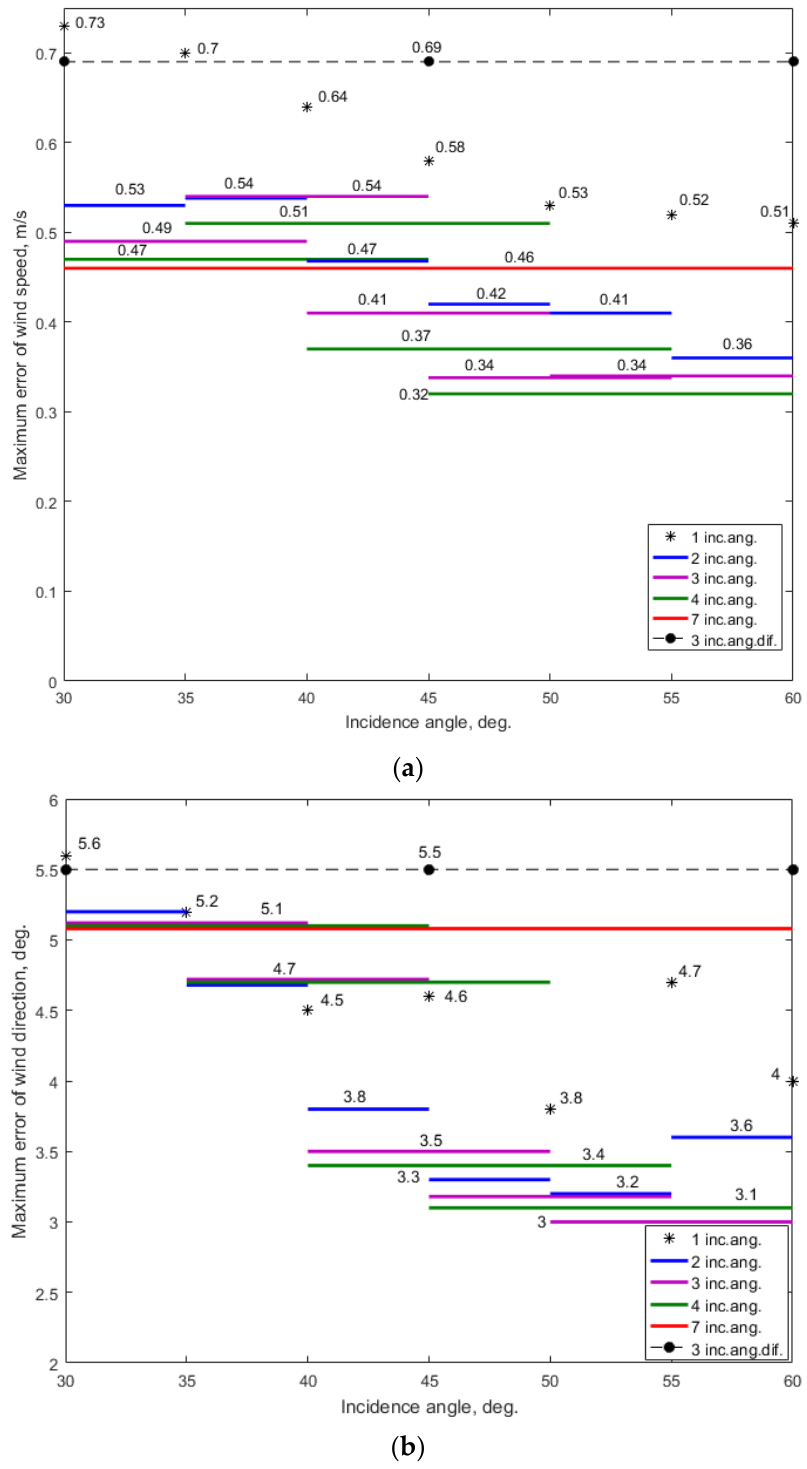
Figure 5. Circular NRCS sampling scheme results: ( a ) wind speed maximum error; ( b ) wind direction maximum error. The black asterisks are for the case of a single incidence angle; the blue lines are for the case of 2 incidence angles; the purple lines are for the case of 3 incidence angles; the green lines are for the case of 4 incidence angles; the red line is for the case of 7 incidence angles; and the black, dashed line with dots is for the particular case of the 3 incidence angles of 30°, 45°, and 60° [17].